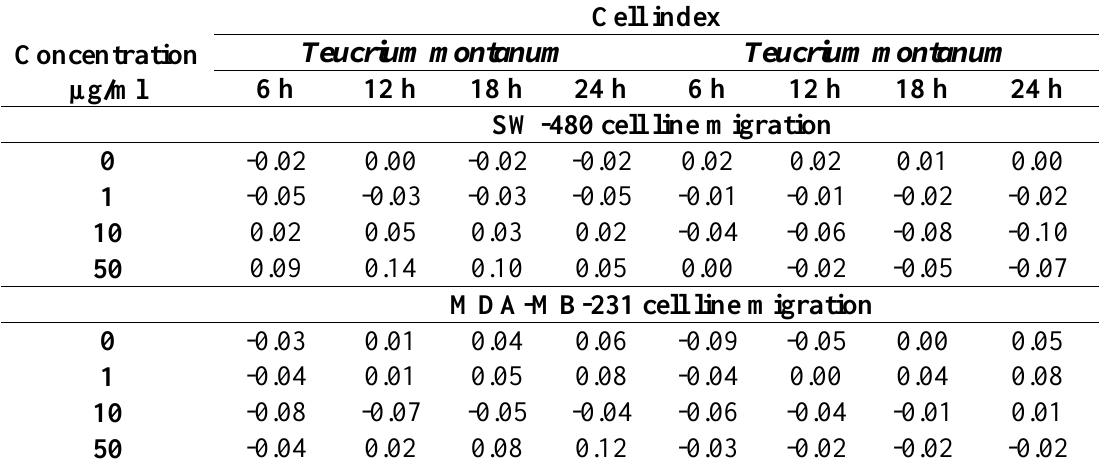
Table 4. Effects of Т . montanum and Т . polium extracts on migration of